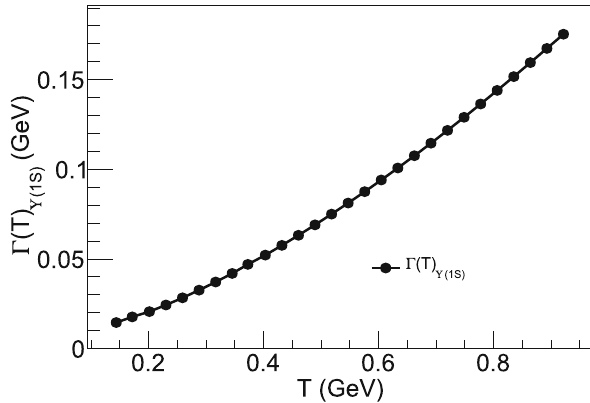
Fig. 1 Temperature dependence of the in-medium decay width ( (cid:10)( T ) ) of ϒ( 1 S )